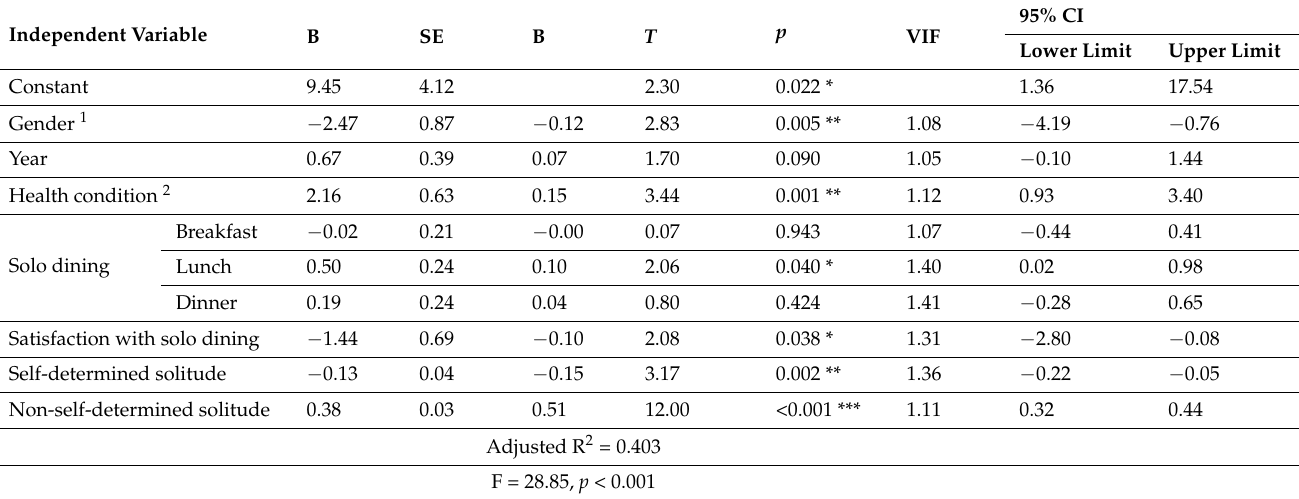
Table 4. Factors influencing depression ( N =